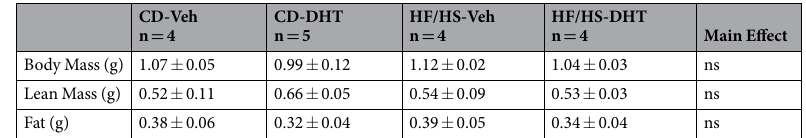
Table 2. Fetal body composition was assessed by Body Composition Analyzer (BCA), Bruker minispec LF110. CD, control diet; HF/HS, high fat diet; Veh, vehicle; DHT, dihydrotestosterone. ns: no significance. Data are Mean values ± SEM and were analyzed by 2-way ANOVA to investigate interactions between maternal diet and DHT injection or main effects of either maternal diet or DHT.